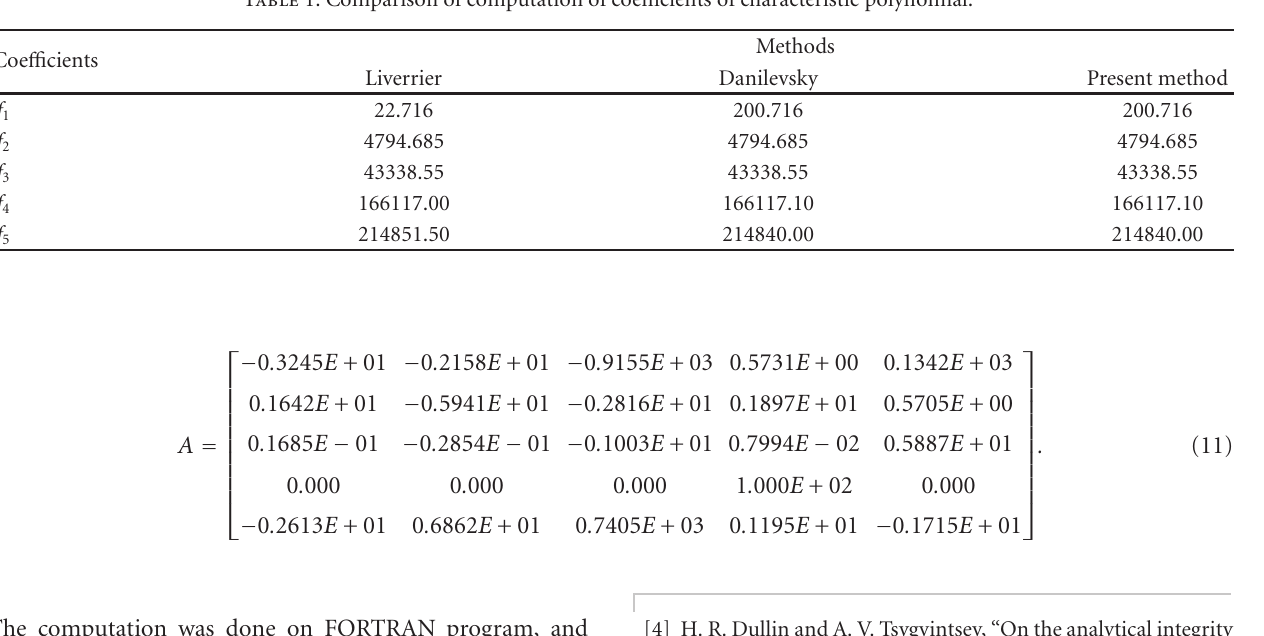
Table 1: Comparison of computation of coe ffi cients of characteristic